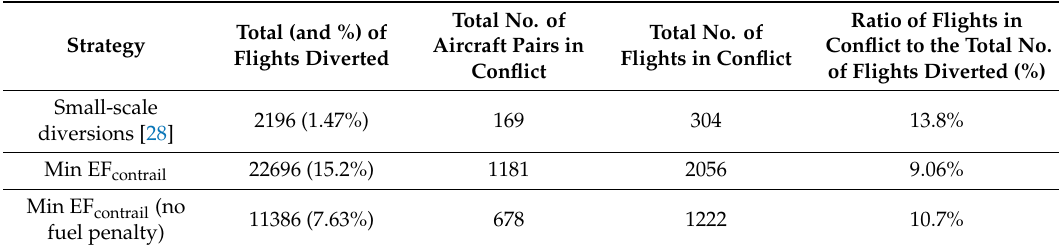
Table 2. Total number (and percentage) of flights diverted, and summary statistics of the resulting air tra ffi c management (ATM) conflicts for: (i) the small-scale diversion proposed by Teoh et al. [28]; the minimum EF contrail strategy with (ii) no constraints (Section 3.1.3); and (iii) with constraints where only flights that do not incur a fuel penalty are diverted (Section